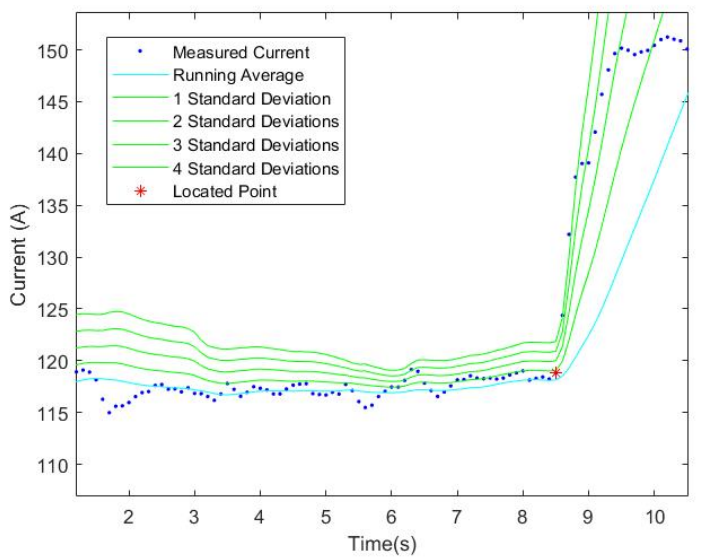
Figure 8. A plot showing measured currents, a running average, and positive multiples of the stand- ard deviation. standard